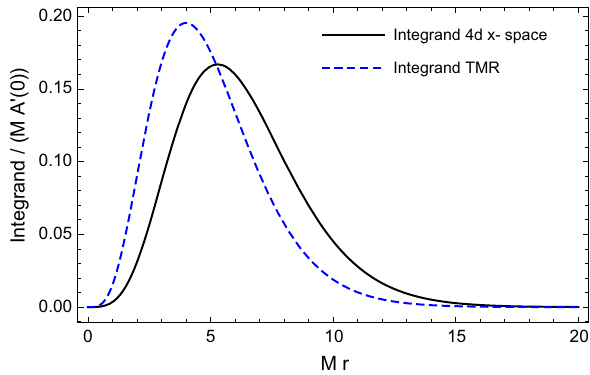
Fig. 2 The integrand in the integral over | x | in Eq. (37) to obtain the Adler function at the origin, A (cid:2) ( 0 ) , is displayed as a continuous curve. For comparison, the dashed curved is the integrand in the integration over Euclidean time in the time-momentum representation; see Eq. (77) . = x with ( r 0 ). In both cases, the model for the spectral function is given by Eq. (66) and the displayed functions are normalized such that the area under the curves is unity. Note that for M = 800MeV, Mr = 4 corresponds to 1fm